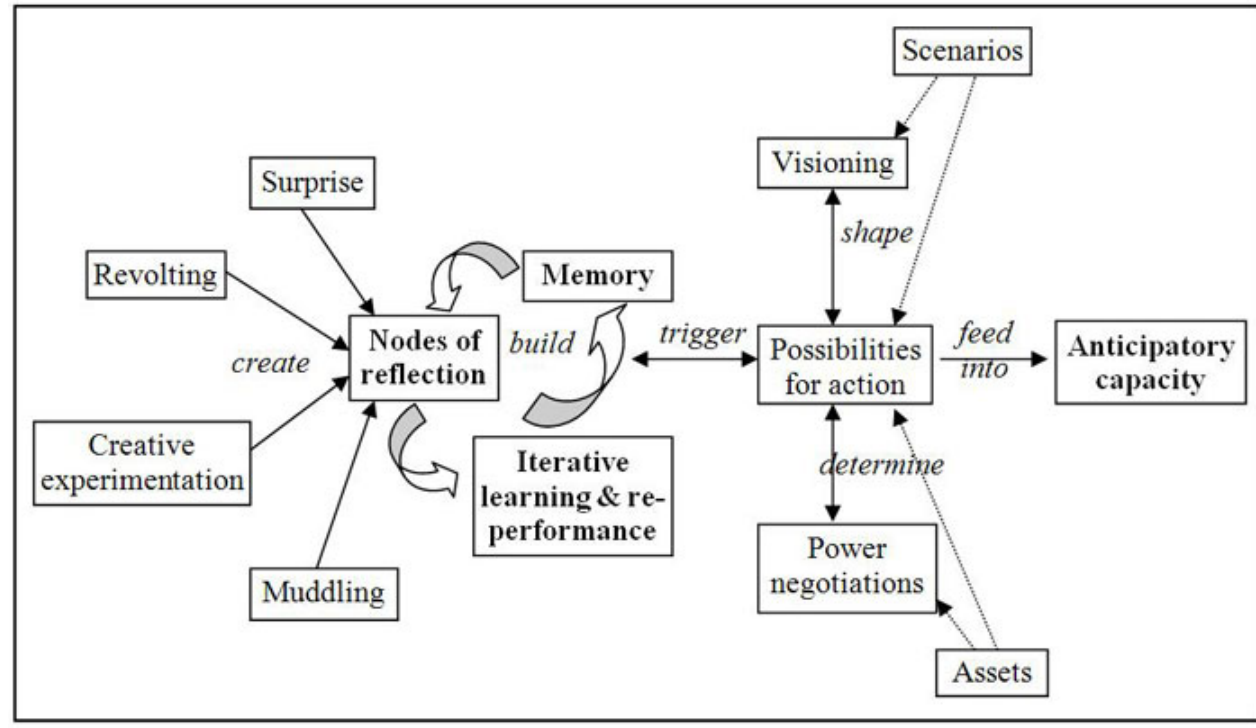
Fig. 5. Elements of a deliberative learning space for building anticipatory